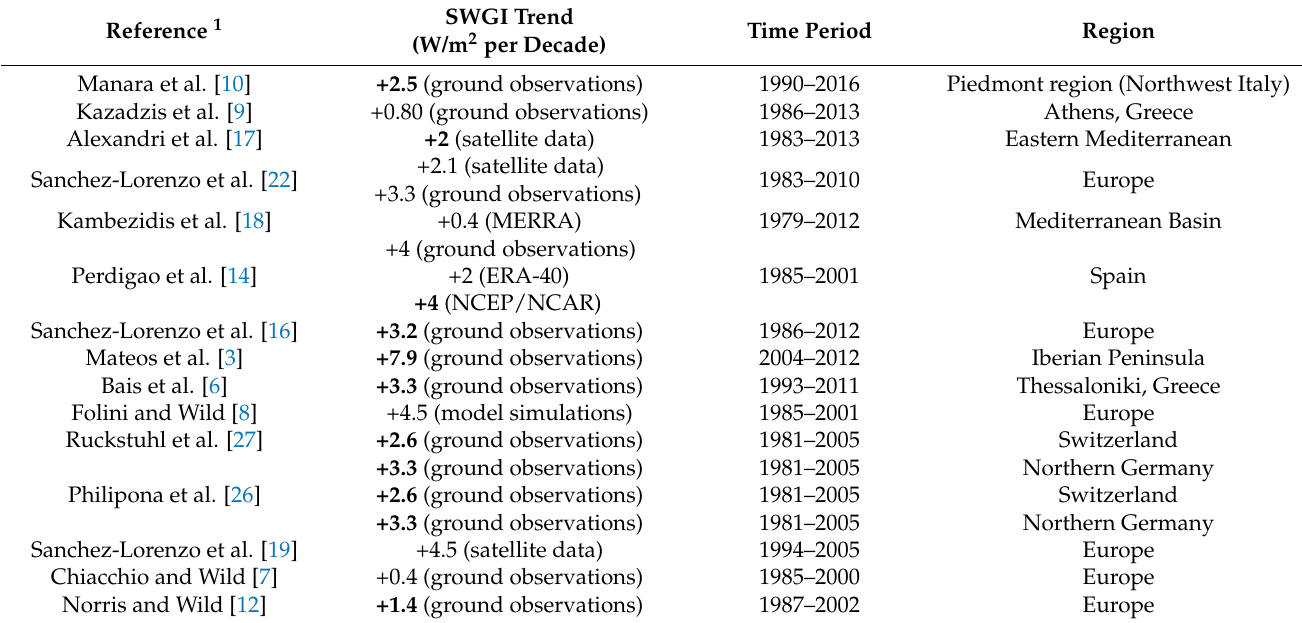
Table 2. Annual trends (W/m 2 per decade) over Euro-Mediterranean area. Bold values indicate significance at the 95% confidence